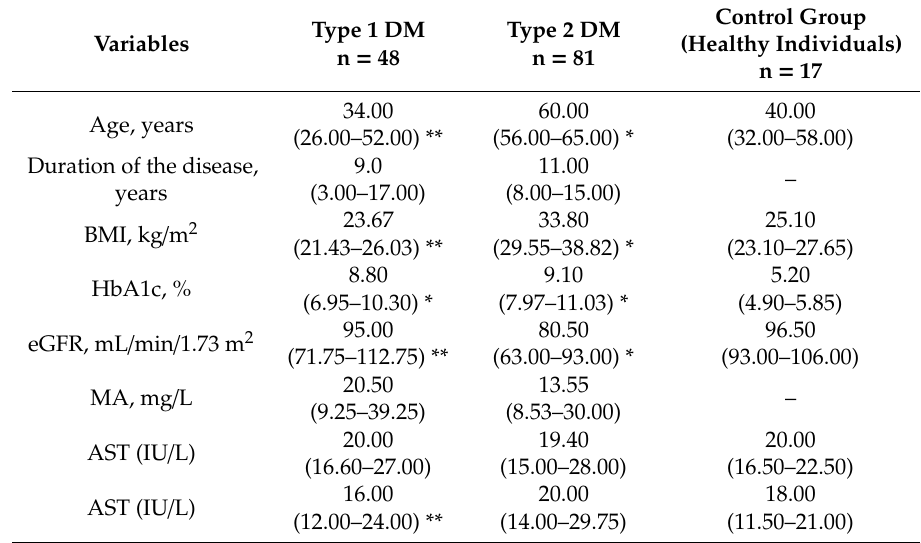
Table 1. Clinical characteristics of patients in the studied